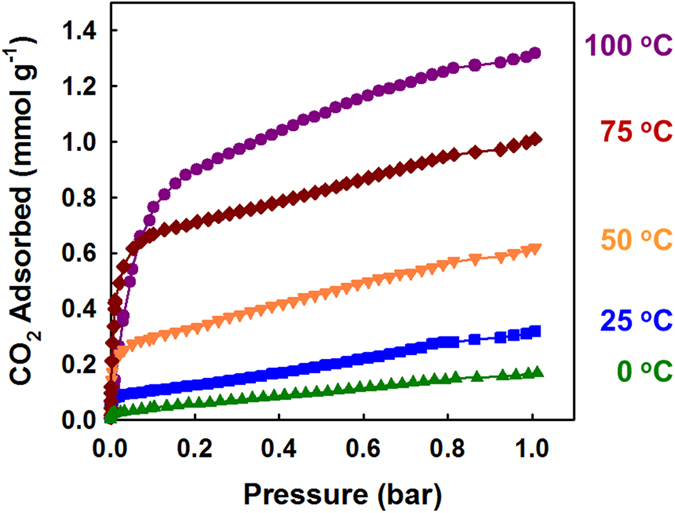
CO2 adsorption isotherms of MOFNH2 obtained at the various temperatures.